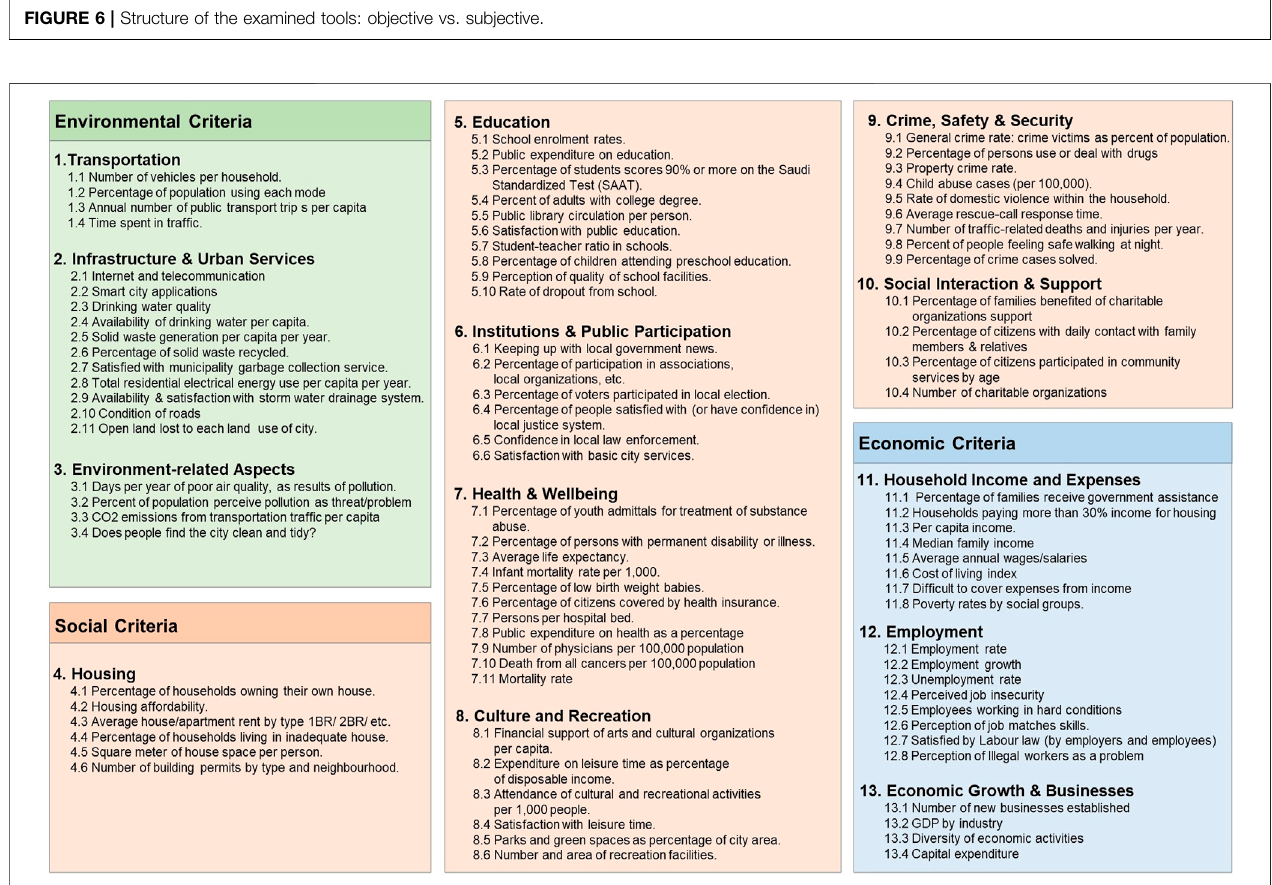
FIGURE 7 | Potential list of QOL indicators and domains selected based on CLC.